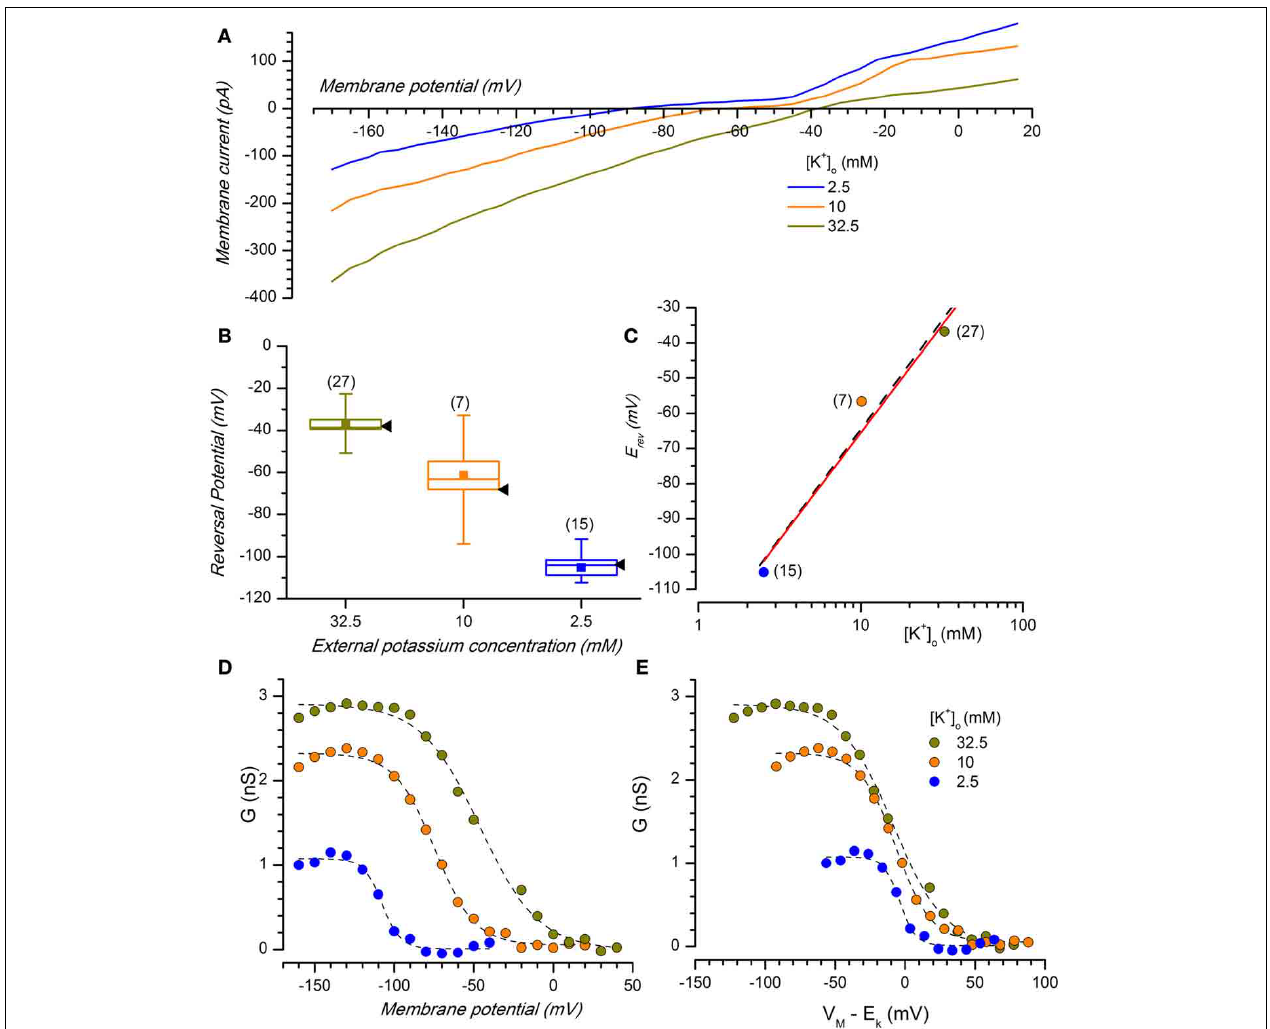
FIGURE 3 | Potassium sensitivity. (A) Effect of changing [K + ]o on membrane current. Average currents ( n = 8) at the indicated external potassium concentrations in response to voltage ramps from − 170 to + 20mV from a holding potential of − 40mV, 0.22V/s; perforated patches; the bathing solution included Bl1 and Bl2. (B) Box charts showing the reversal potentials at different [K + ]o [same color code as in (A) ]; black arrow heads to the right of each box mark the expected reversal potentials predicted by the Nernst equation. In the box charts, here and in the following, the square in the center of the box represents the mean value, the horizontal line crossing the box indicates the median, the range of the box represents standard error and the